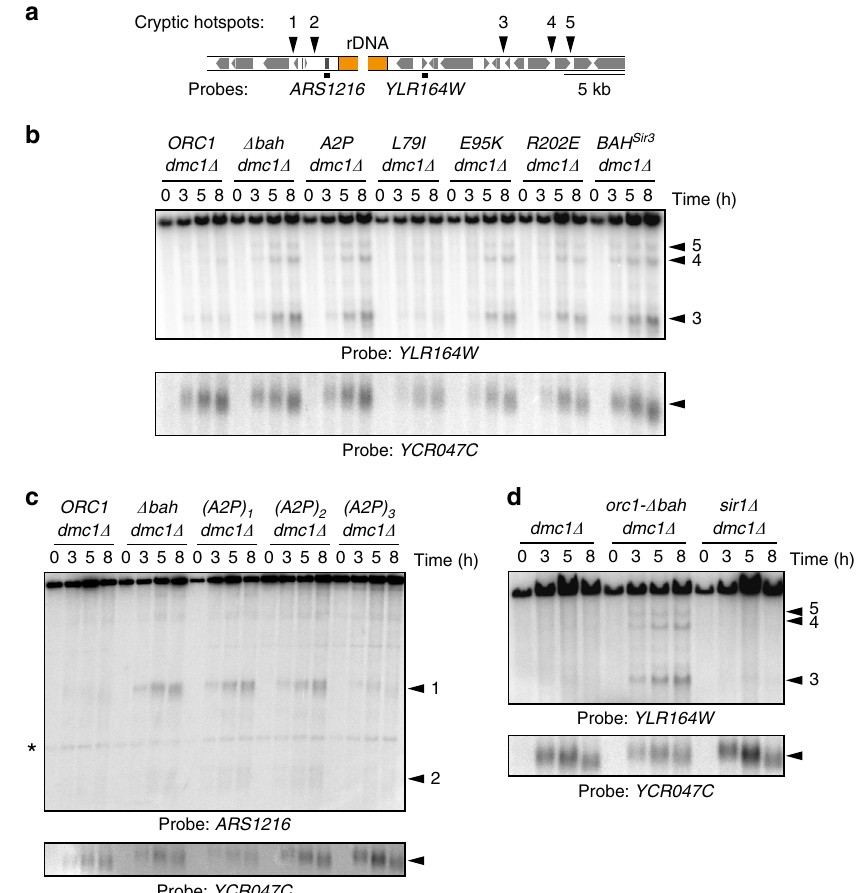
Fig. 6 Orc1-nucleosome contacts protect rDNA borders during meiosis. a Schematic indicating probe locations next to the rDNA used in panels ( b ), ( c ), and ( d ), as well as location of cryptic hotspots with respect to gene bodies (gray boxes). b Effect of Orc1 BAH mutations. Southern blot of the right rDNA fl ank (probe YLR164W ). The dmc1 Δ mutation prevents DSB repair, allowing analysis of total DSB activity. The A2P, E95K, and R202E mutants experience strong DSB activity near the rDNA while L79I does not. Replacement of Orc1 BAH domain with that of Sir3 does not rescue the wt phenotype. DSB formation at the YCR047C locus serves as control for ef fi ciency of meiotic induction. c Dosage effect of Orc1 A2P BAH mutation. Strains carry 1, 2, or 3 integrated copies of the orc1-A2P construct. Southern blot of the left rDNA fl ank (probe ARS1216 ). d Effect of SIR1 deletion (probe YLR164W